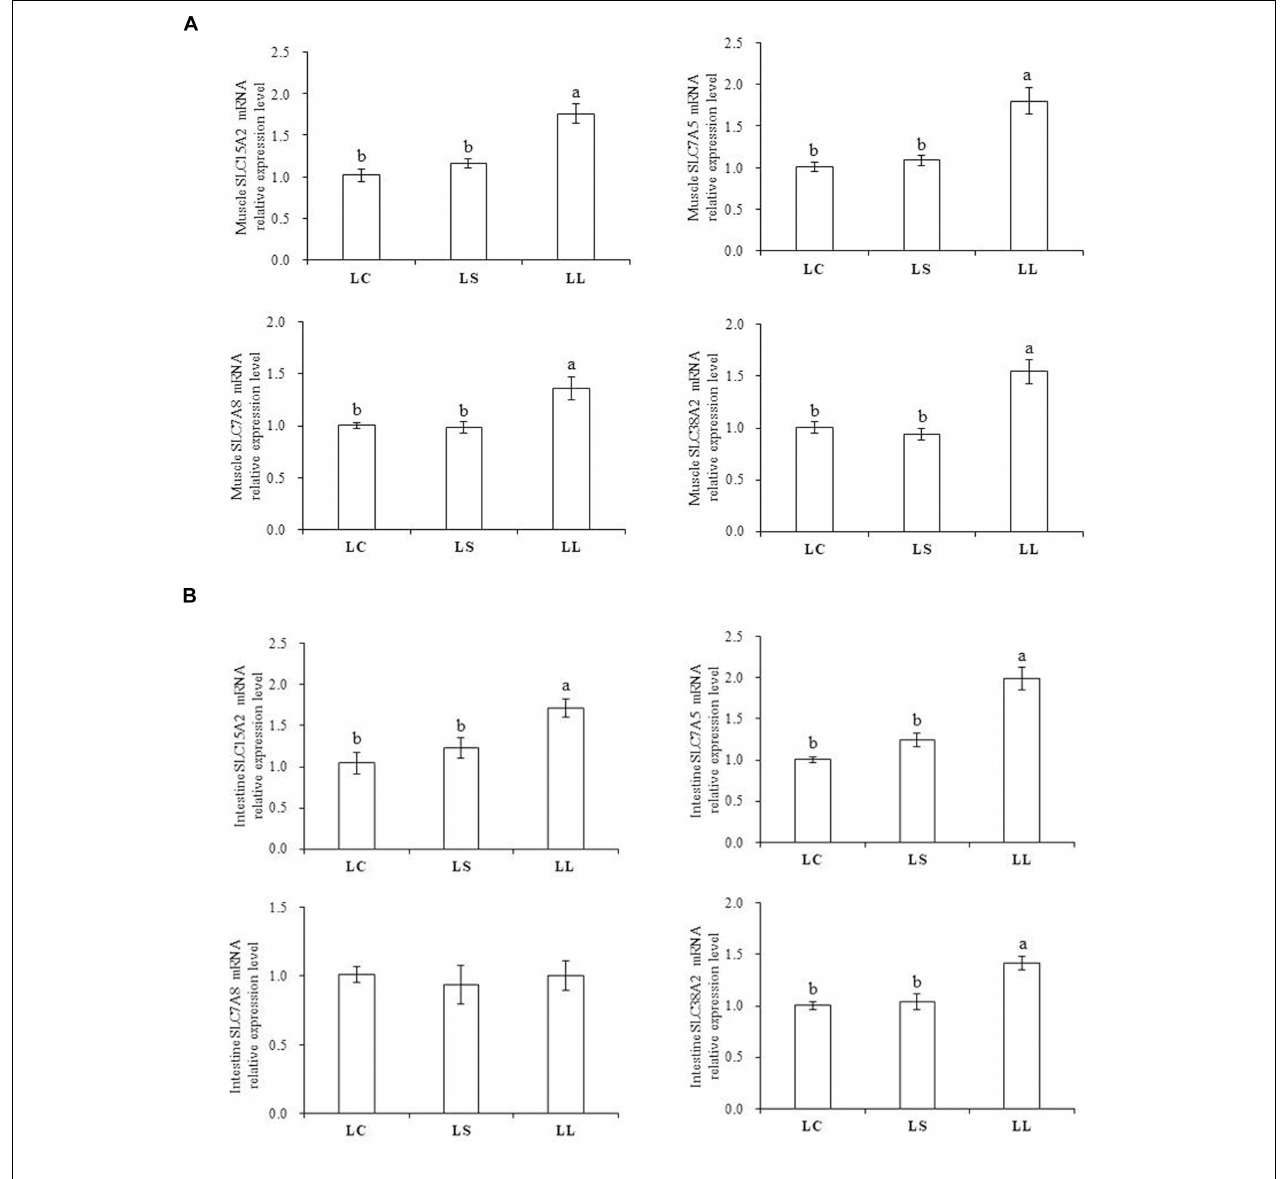
FIGURE 1 | Effects of the LC diet, LL diet supplemented with dietary lysine (LS diet) and the LL diet on peptide and AA transporters mRNA expression in muscle (A) and intestine (B) . Different superscript letter “a, b” indicated statistical significant differences ( P < 0 . 05; mean ± SEM, n = 6).